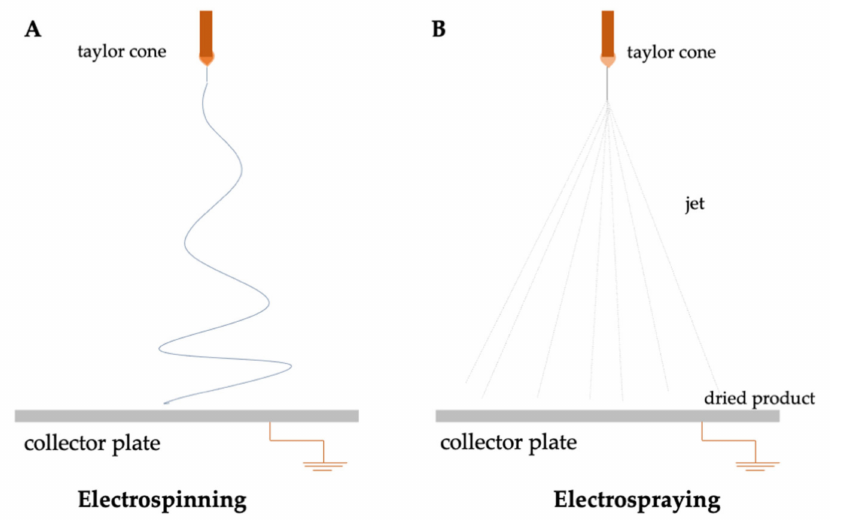
Figure 5. Schematic illustration of the basic setup for ( A ) electrospinning and ( B )